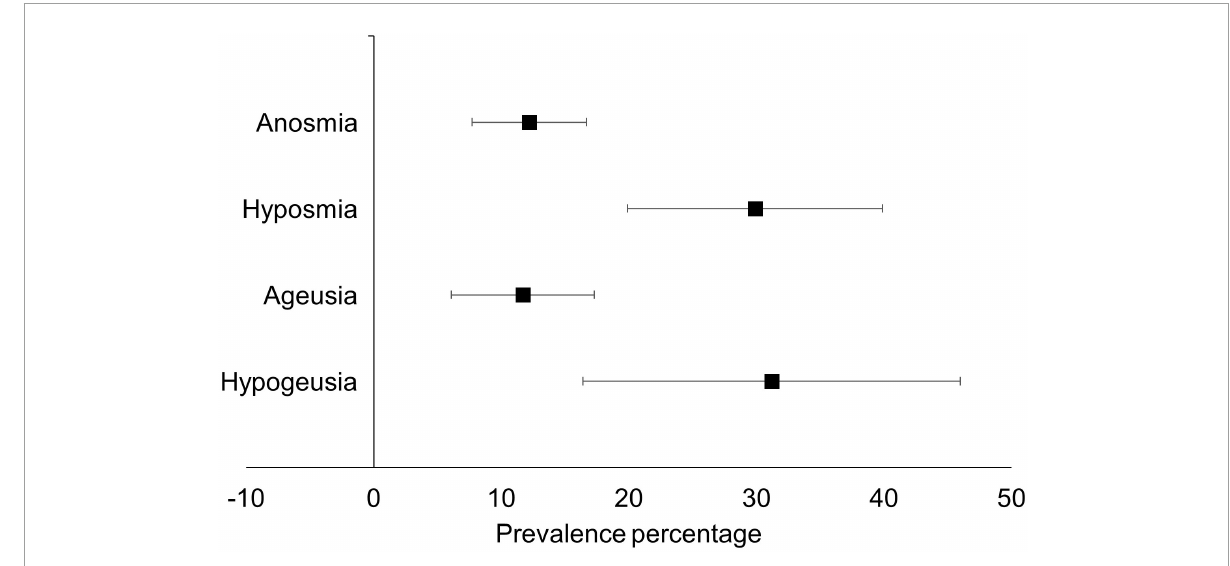
FIGURE2 Meta-analytic prevalence of smell and taste related sensory loss in post-COVID